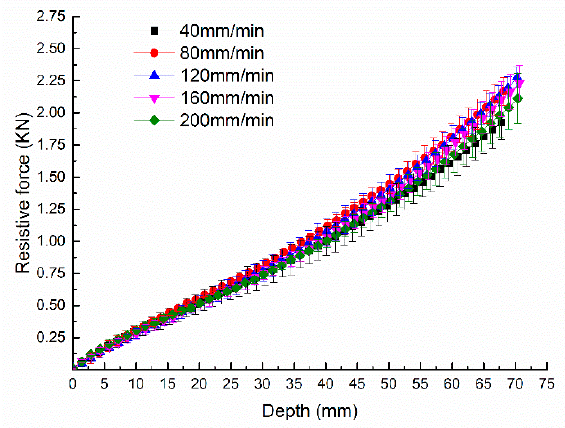
Figure 5. Influence of intrusion velocity on the intrusion resistive force.